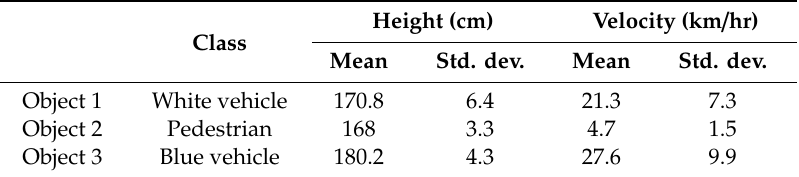
Table 2. The observed geometric attributes.